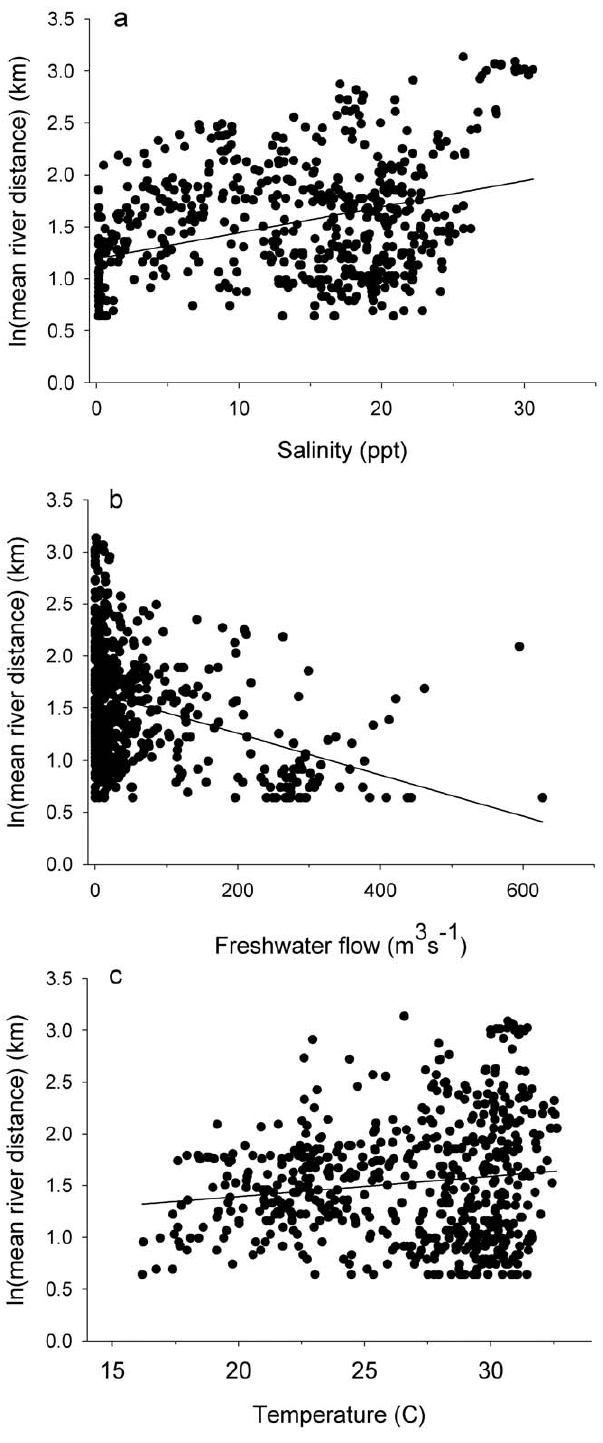
Figure 5. Relationship between distribution of tagged sawfish and environmental parameters. (a) salinity, (b) freshwater flow and (c) temperature.